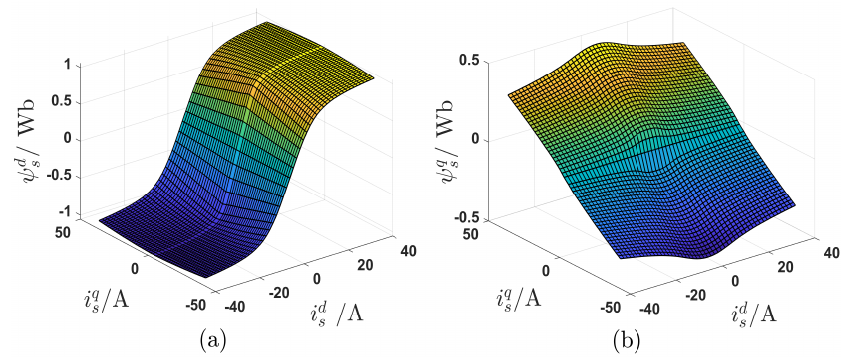
Figure 2. The nonlinear flux linkages of a real 9.6 kW SynRM obtained from FEM data: ( a ) d-axis component ψ d s , and ( b ) q-axis component ψ q s .